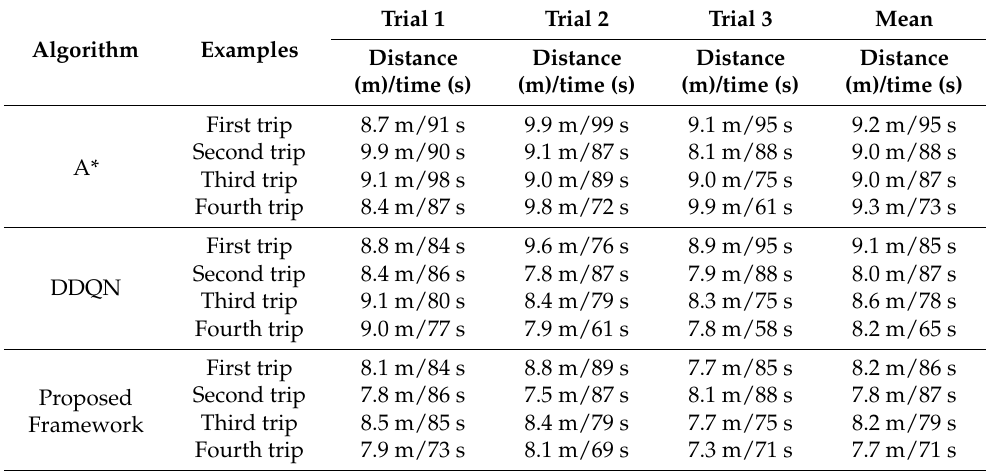
Table 4. Experimental data of A*, DDQN and the proposed framework algorithm.